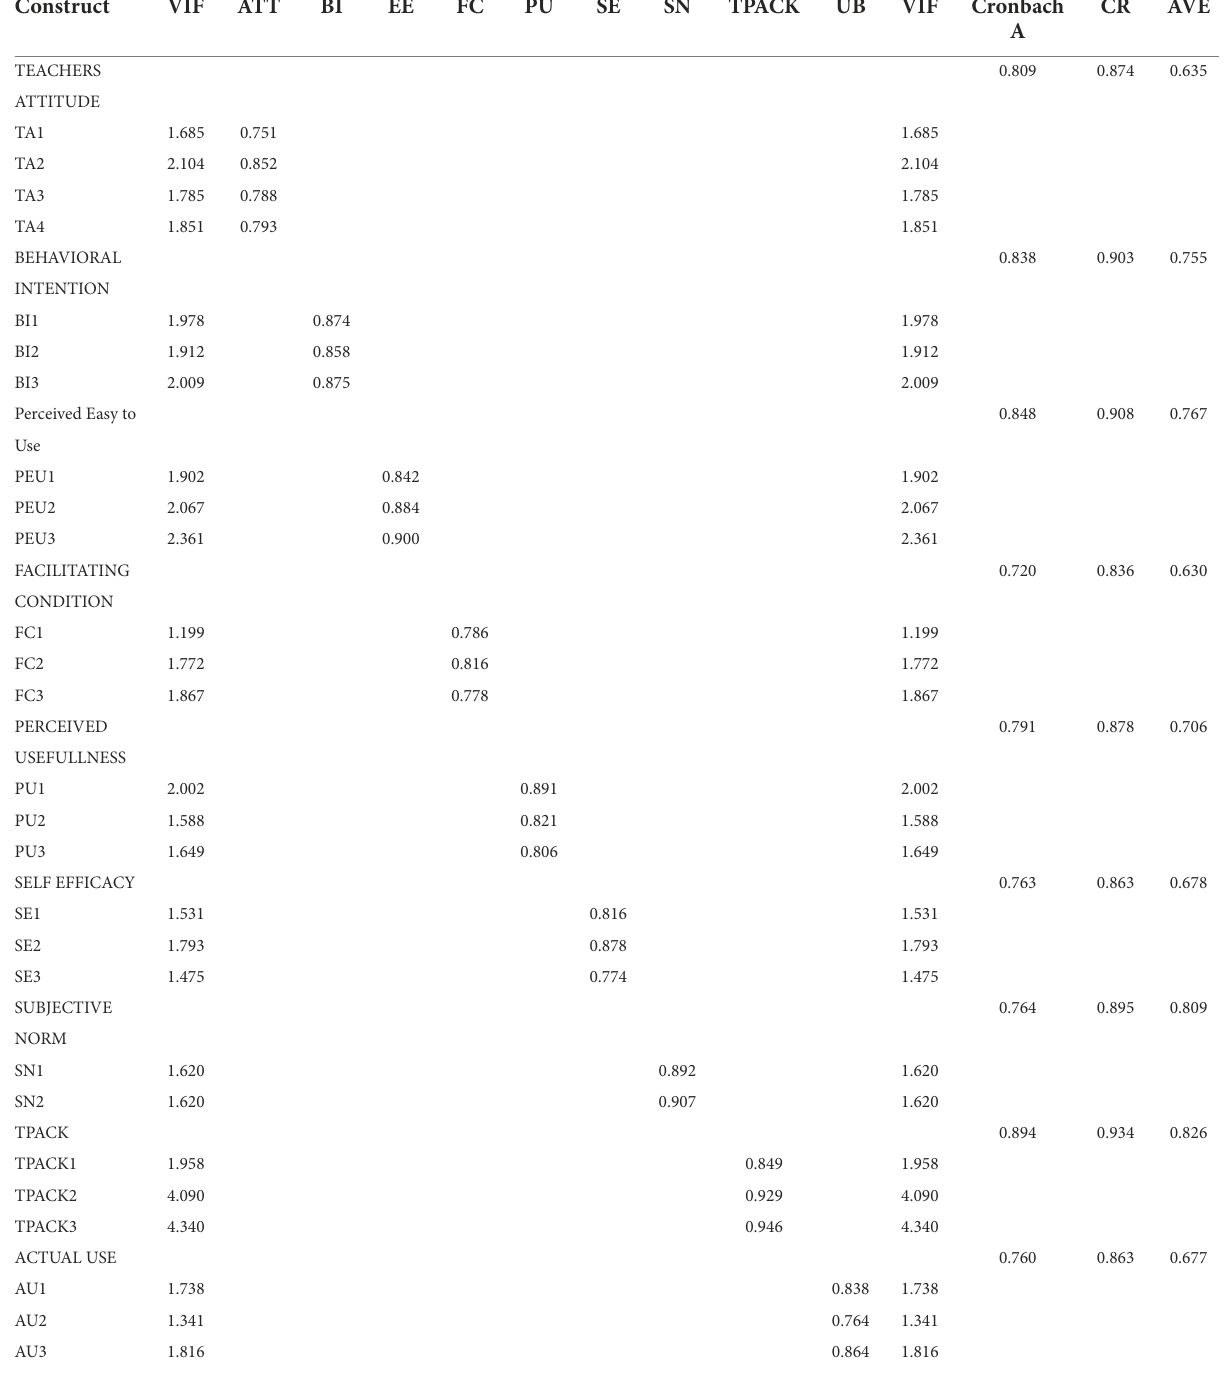
TABLE 3 Factor loadings, VIF, reliability and validity